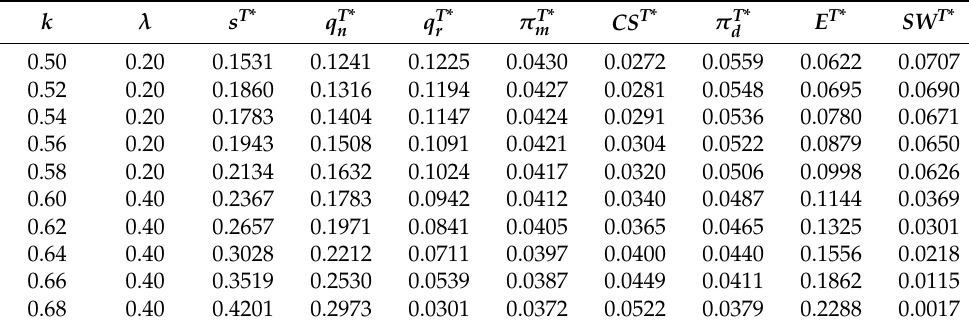
Table 6. The sensitivity analysis results for Model